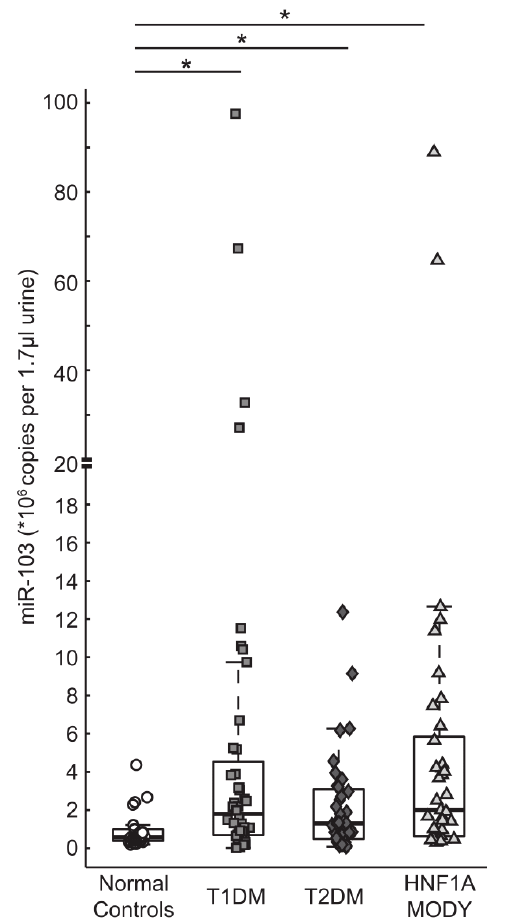
Figure 3. miR-103 levels detected in urine. Copies of miRNA per reaction were determined by quantitative qPCR in urine samples of T1DM ( n = 44), T2DM ( n = 36), HNF1A-MODY mutation carriers ( n = 38) and normal control ( n = 26) subjects. Box plots depict median and inter quartile range. Levels of miR-103 were statistically higher in all disease groups compared to normal controls where HNF1A-MODY mutation carriers showed the highest expression values ( * significant differences by Mann-Whitney